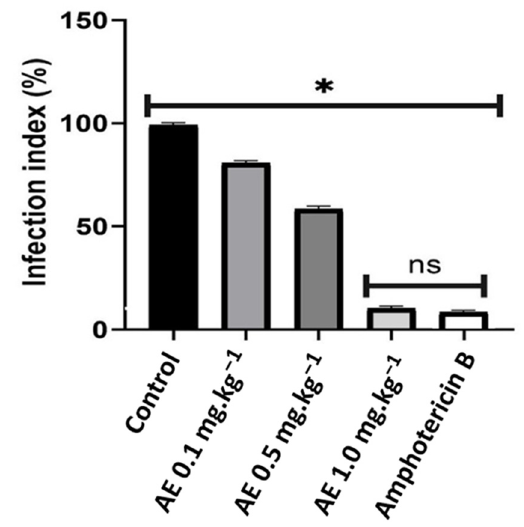
Figure 4. Infection index of macrophages infected with Leishmania braziliensis after 4 weeks of treat- ment. The data represent the mean values of the infection index counted by imprinting lesion frag- ments stained with Giemsa and counted in 1000 × . Negative control: animals infected and untreated. Positive control: animals treated with Amphotericin B 5 mg·kg − 1 . Treatment EA 0.1 mg·kg − 1 , EA 0.5 mg·kg − 1 , EA 1.0 mg·kg − 1 . The data represent the mean ± SD from 6 hamsters/group. * p < 0.05 when compared with all groups. ns p > 0.05.